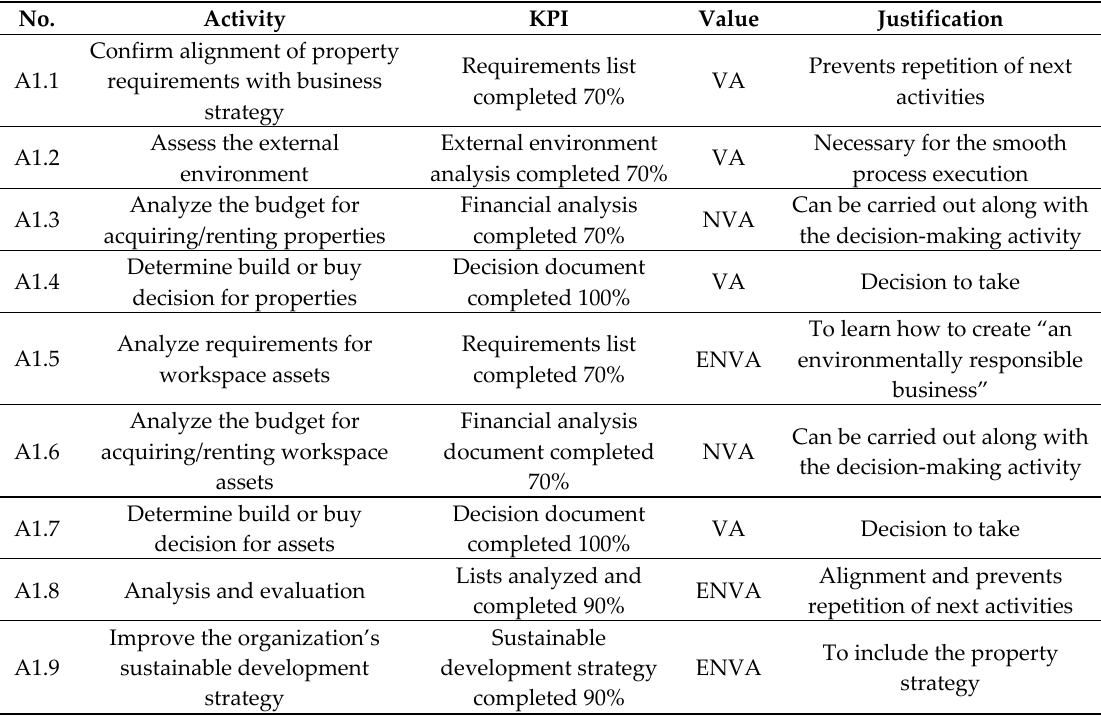
Table 2. P1 process-initial